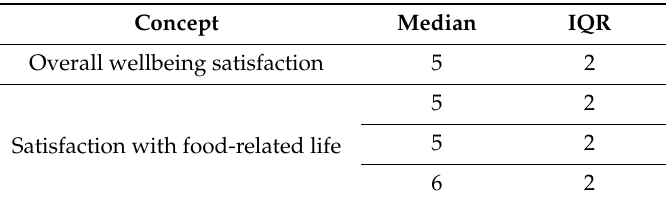
The median and Inter-Quartile Range (IQR) of consumers’ overall satisfaction with life and satisfaction with food-related lifestyle (1 = strongly disagree, 7 = strongly agree) and (1 = strongly dissatisfied, 7 = strongly